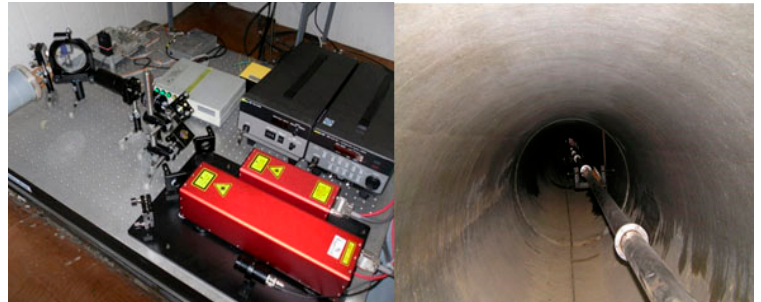
Figure 1. Modernized 52.5 m laser strainmeter. The central interference unit with a frequency-stabilized helium–neon laser, which is stabilized along the iodine lines (frequency stability 10 − 11 , ( left) ), as well as an underground beam guide ( right ).